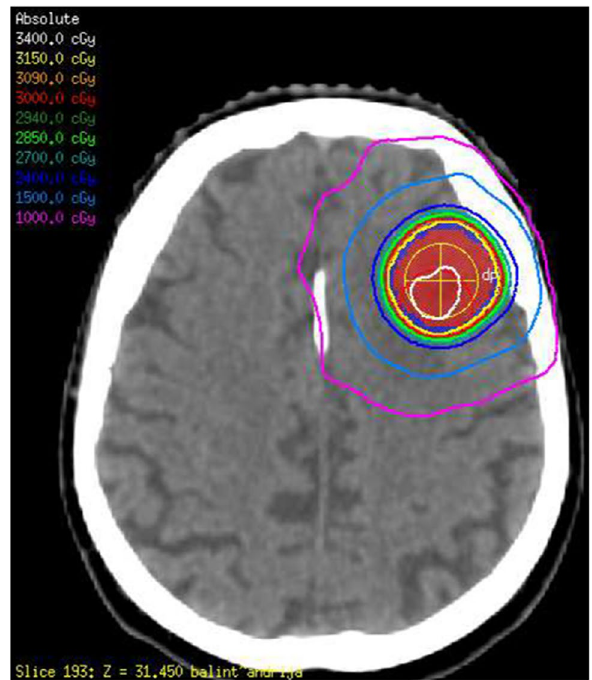
Figure 1. Treatment planning CT with the radiation isodose lines for a representative patient treated with 30 Gy in five fractions to a 2.7 cm frontal